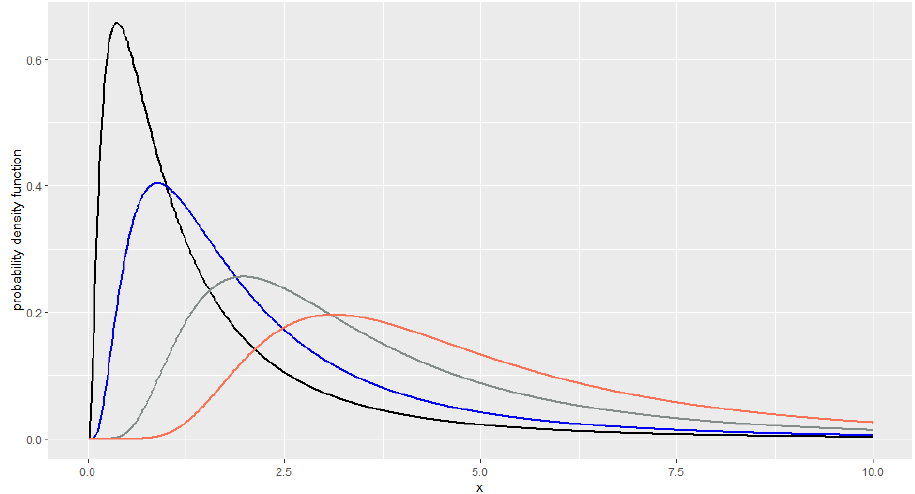
Figure 1. The plot of PDF of the standard LPN distribution for γ = 1, 2, 5, 10 (mode